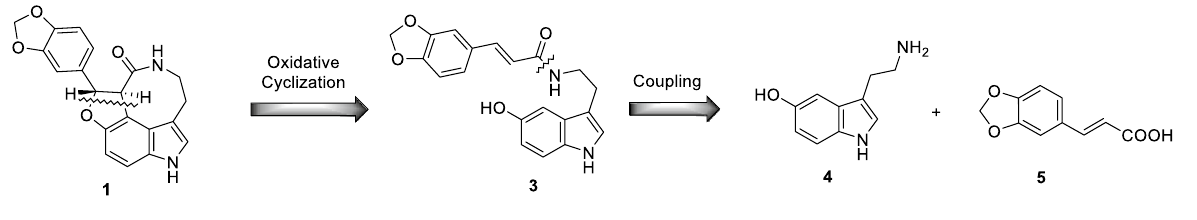
Figure 2. Retrosynthetic pathway of (±)-decursivine 1 .